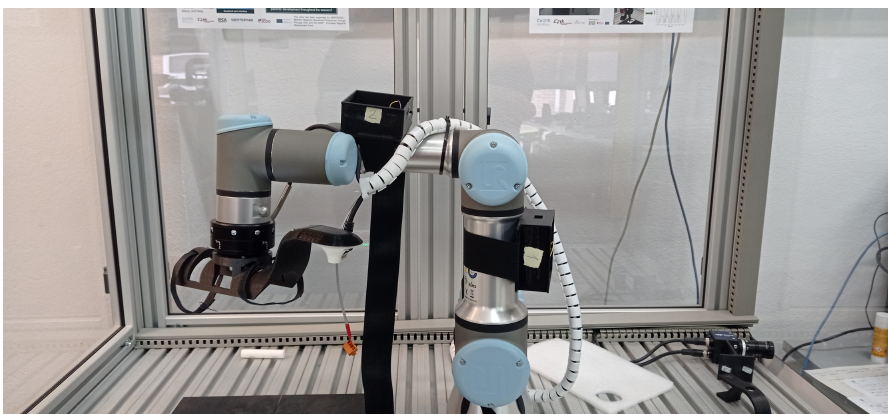
Figure 8. Wearable modules attached to the UR3 robot.